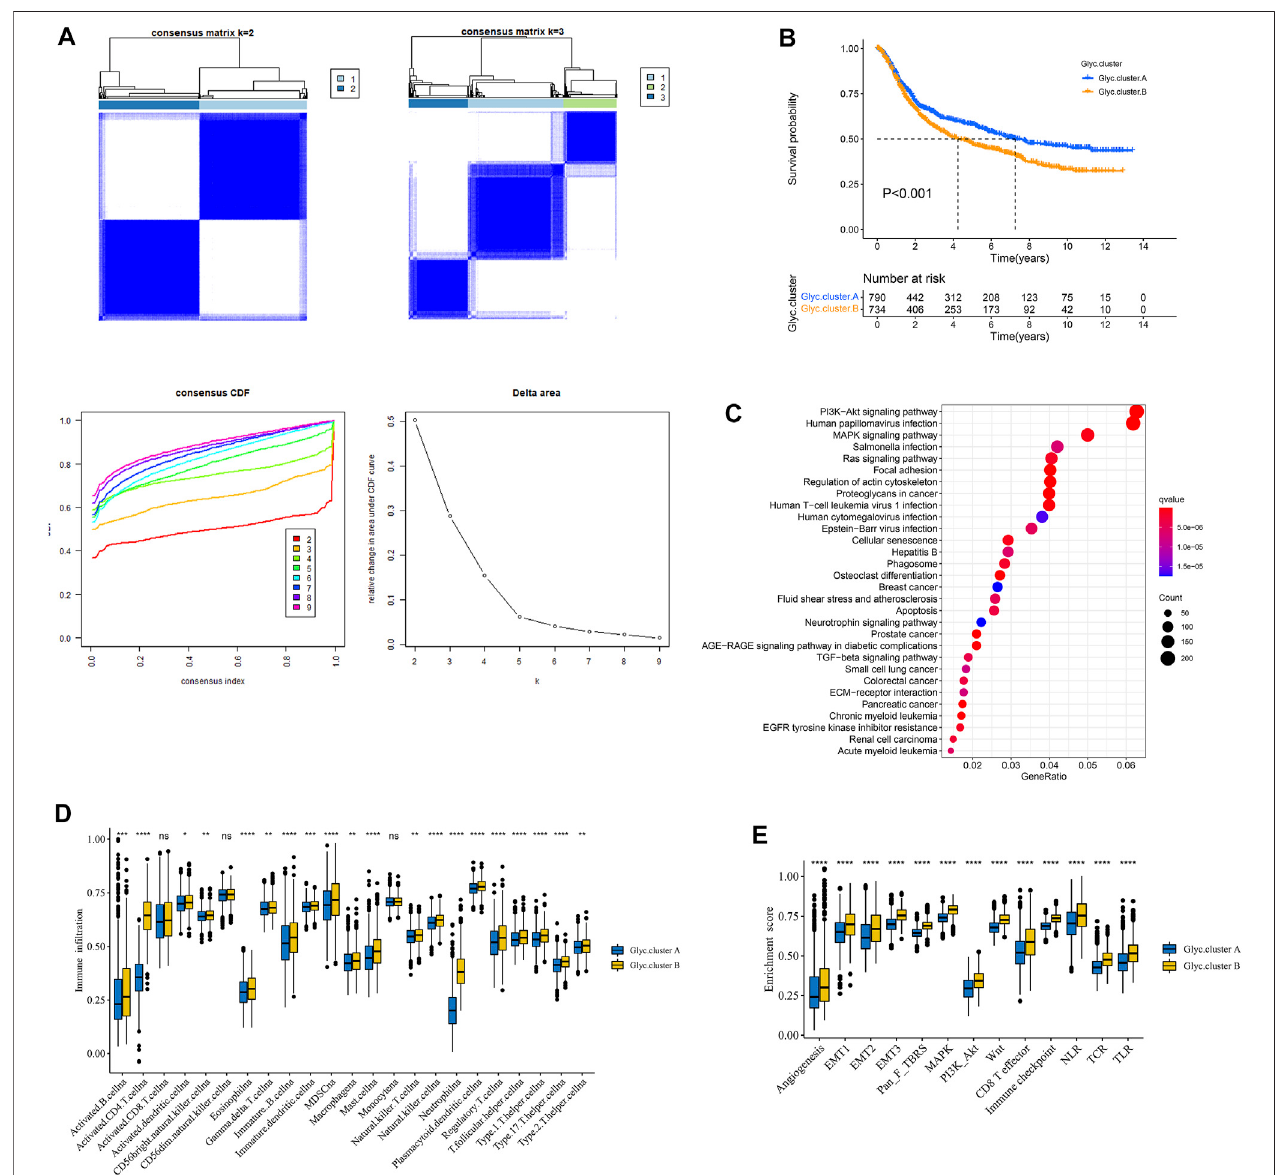
FIGURE3| Patternsofglycosylation andfunctionalenrichmentanalysis. (A) Unsupervisedconsensus clusteringfor1,524gastric cancerpatients inametacohort (GSE84437, GSE34942, GSE15459, GSE57303, GSE62254, GSE29272, and TCGA-STAD). (B) Kaplan – Meier curve showed a signi fi cant difference between the two glycosylation(Glyc)clusters.TheyellowrepresentedGlyc.cluster (B) ,andthebluerepresentedGlyc.cluster.A. (C) KEGGenrichmentanalysis.Theillustrationwasused to visualize these biological processes, where red represented activated pathways and blue represented inhibited pathways. (D) The abundance of each TME in fi ltratingcellintwoGlycclusters.Theupperandlowerendsoftheboxesrepresentedtheinterquartilerangeofvalues.Thelinesintheboxesrepresentedmedianvalue, and black dots showed outliers. (E) Differences in stroma-activated pathways including EMT, TGF beta, and angiogenesis pathways among two Glyc clusters. The asterisks represented the statistical p -value (* p < 0.05; ** p < 0.01; *** p < 0.001; **** p < 0.0001).